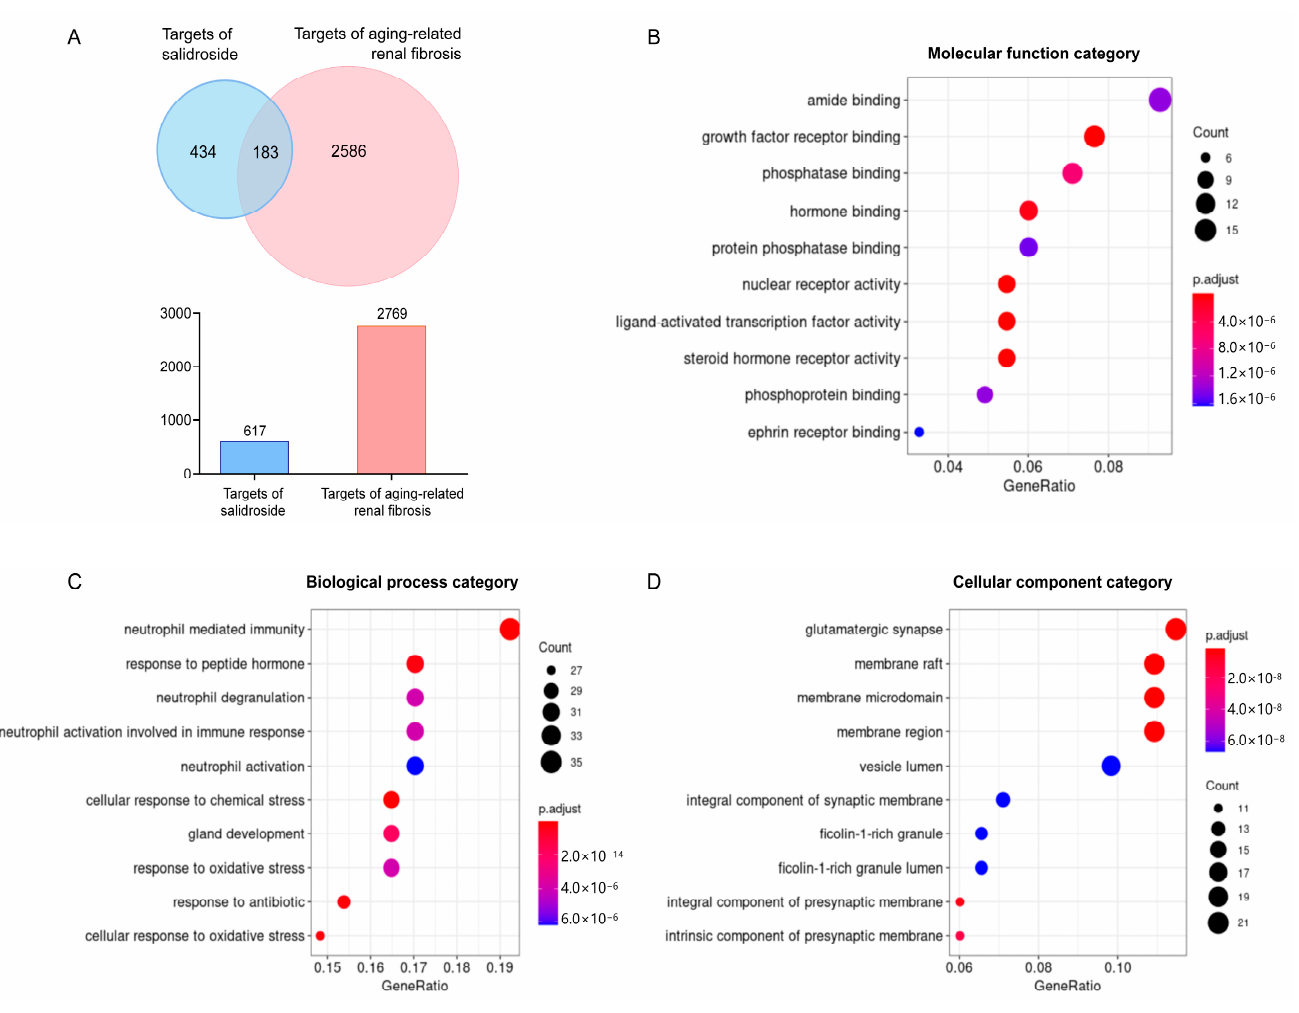
Figure 1. Potential-target screening and enrichment analysis. ( A ) The predicted targets of SAL and aging-related renal fibrosis. A total of 183 overlap targets were screened by the Venn diagram. The bubble maps of molecular function ( B ), biological process ( C ), and cellular component ( D ).